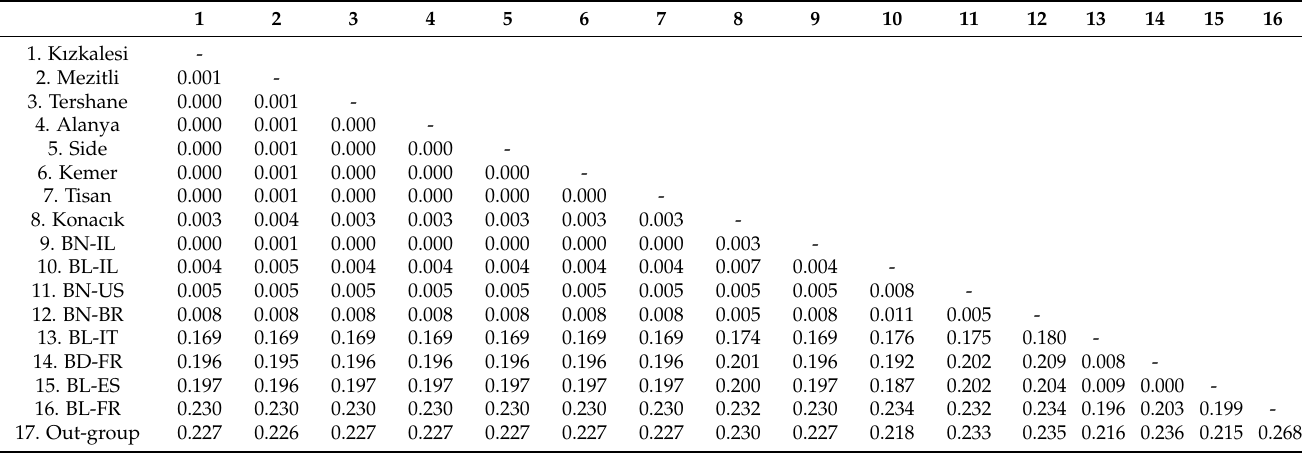
Table 1. Pairwise mean COI distances between the NEMS populations and reference populations.